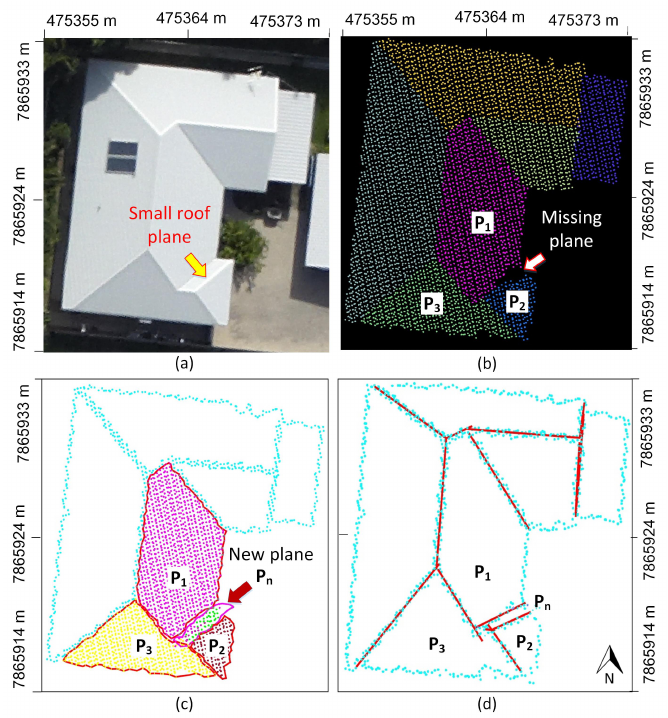
Figure 2. Insertion of a missing plane: ( a ) test building image for demonstration; ( b ) input roof planes for corresponding building and the location of a missing plane; ( c ) new roof plane using unsegmented LiDAR points (green) and points from neighbours; and ( d ) 3-D intersection lines between roof